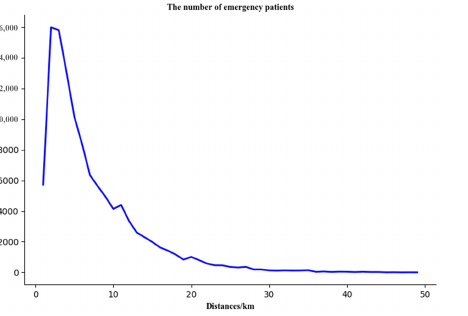
Figure 2. Distance attenuation of the number of emergency patients in Wuhan